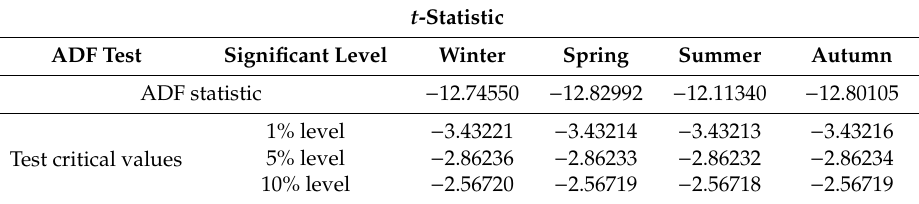
Table 1. Augmented Dickey–Fuller test on maximum temperature data.